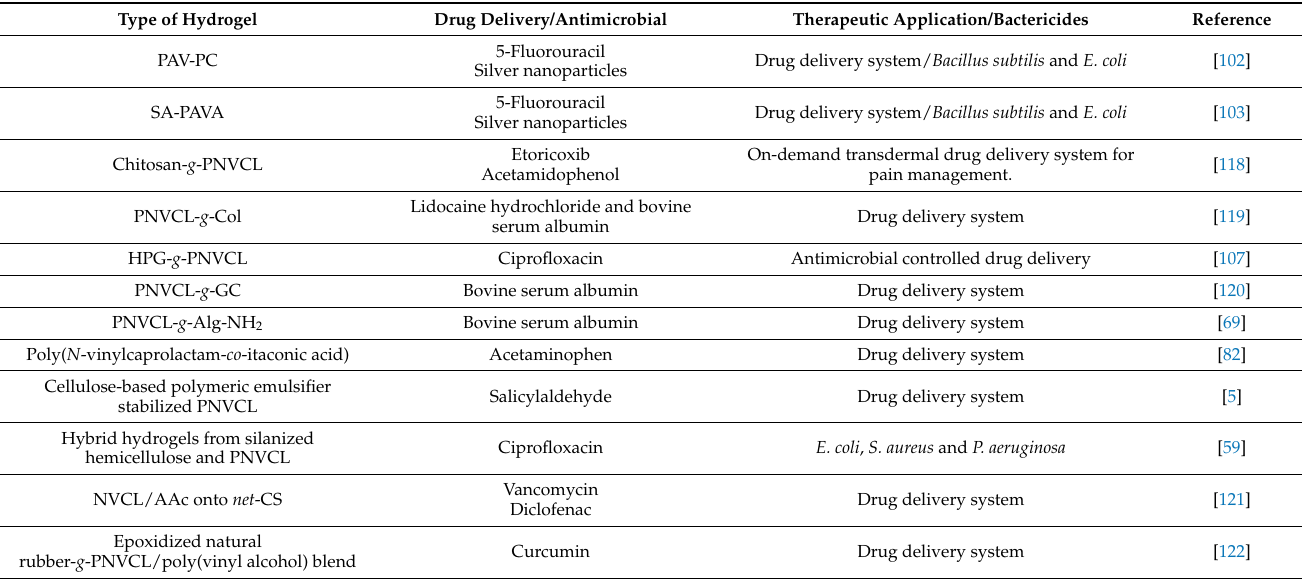
Table 3. Compendium of the novel studies in recent years on PNVCL hydrogel systems for antimi- crobial and drug-release